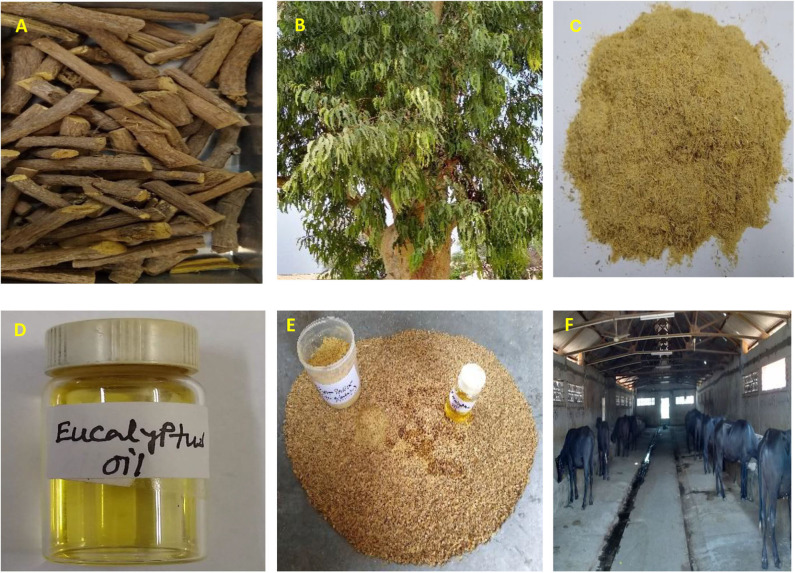
Preparation and supplementation of eucalyptus oil–mulethi powder blend to buffalo calves. (A) Mulethi roots. (B) Eucalyptus tree. (C) Grounded mulethi roots by Willy grinder. (D) Eucalyptus oil. (E) Requisite quantities of Mulethi root powder and eucalyptus oil were placed into a small portion of concentrate mixture and mixed uniformly. (F) The premix was placed into the manger and mixed with the other portion of concentrate mixture and fed to buffalo calves.